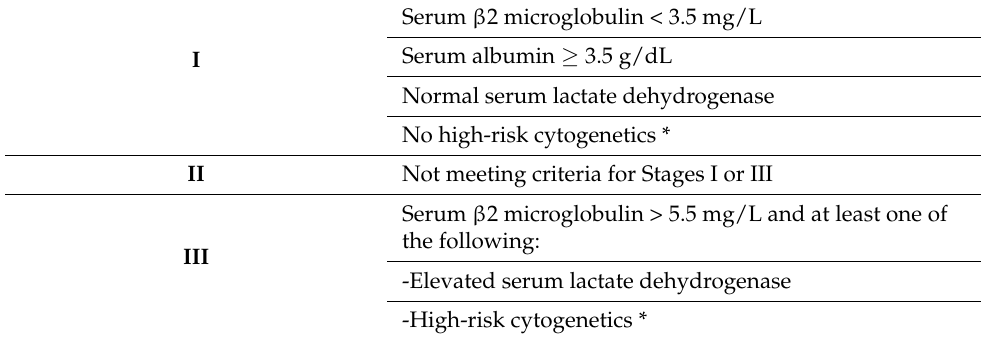
Table 1. Revised International Staging System (R-ISS) stages according to Palumbo et al. [63].